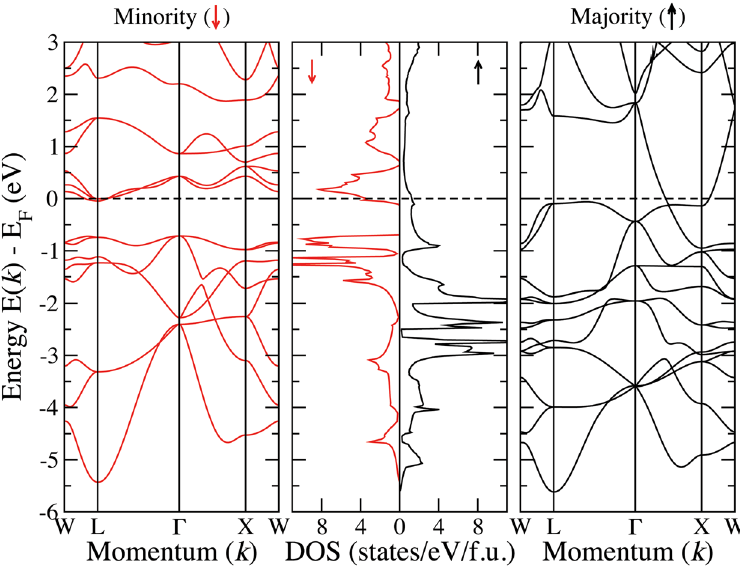
Figure 8. Spin-resolved band structure and density of states for CoYMnSi.